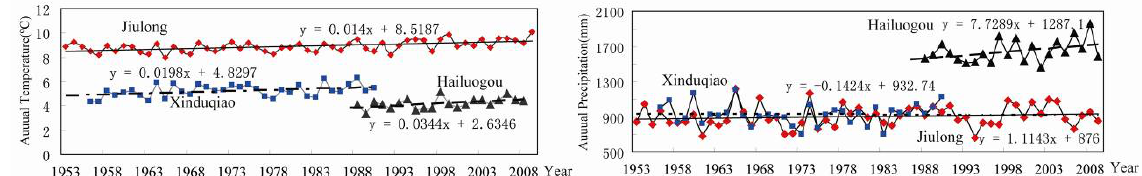
Fig. 6. Meteorological (mean annual temperature and annual precipitation) data for Gongga Mountain from 1960 to 2009.